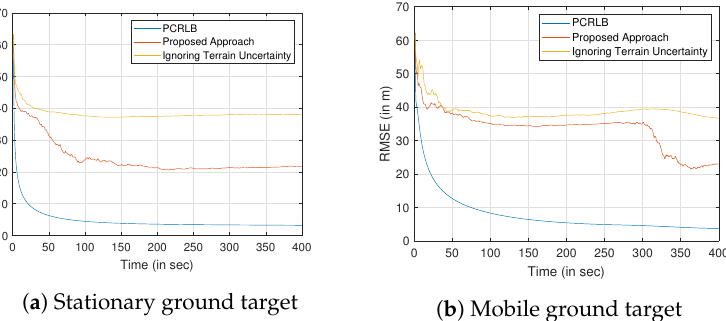
Figure 15. Comparison of the RMSE of the proposed approach with an approach that ignores the terrain uncertainty, when the σ z t = 30